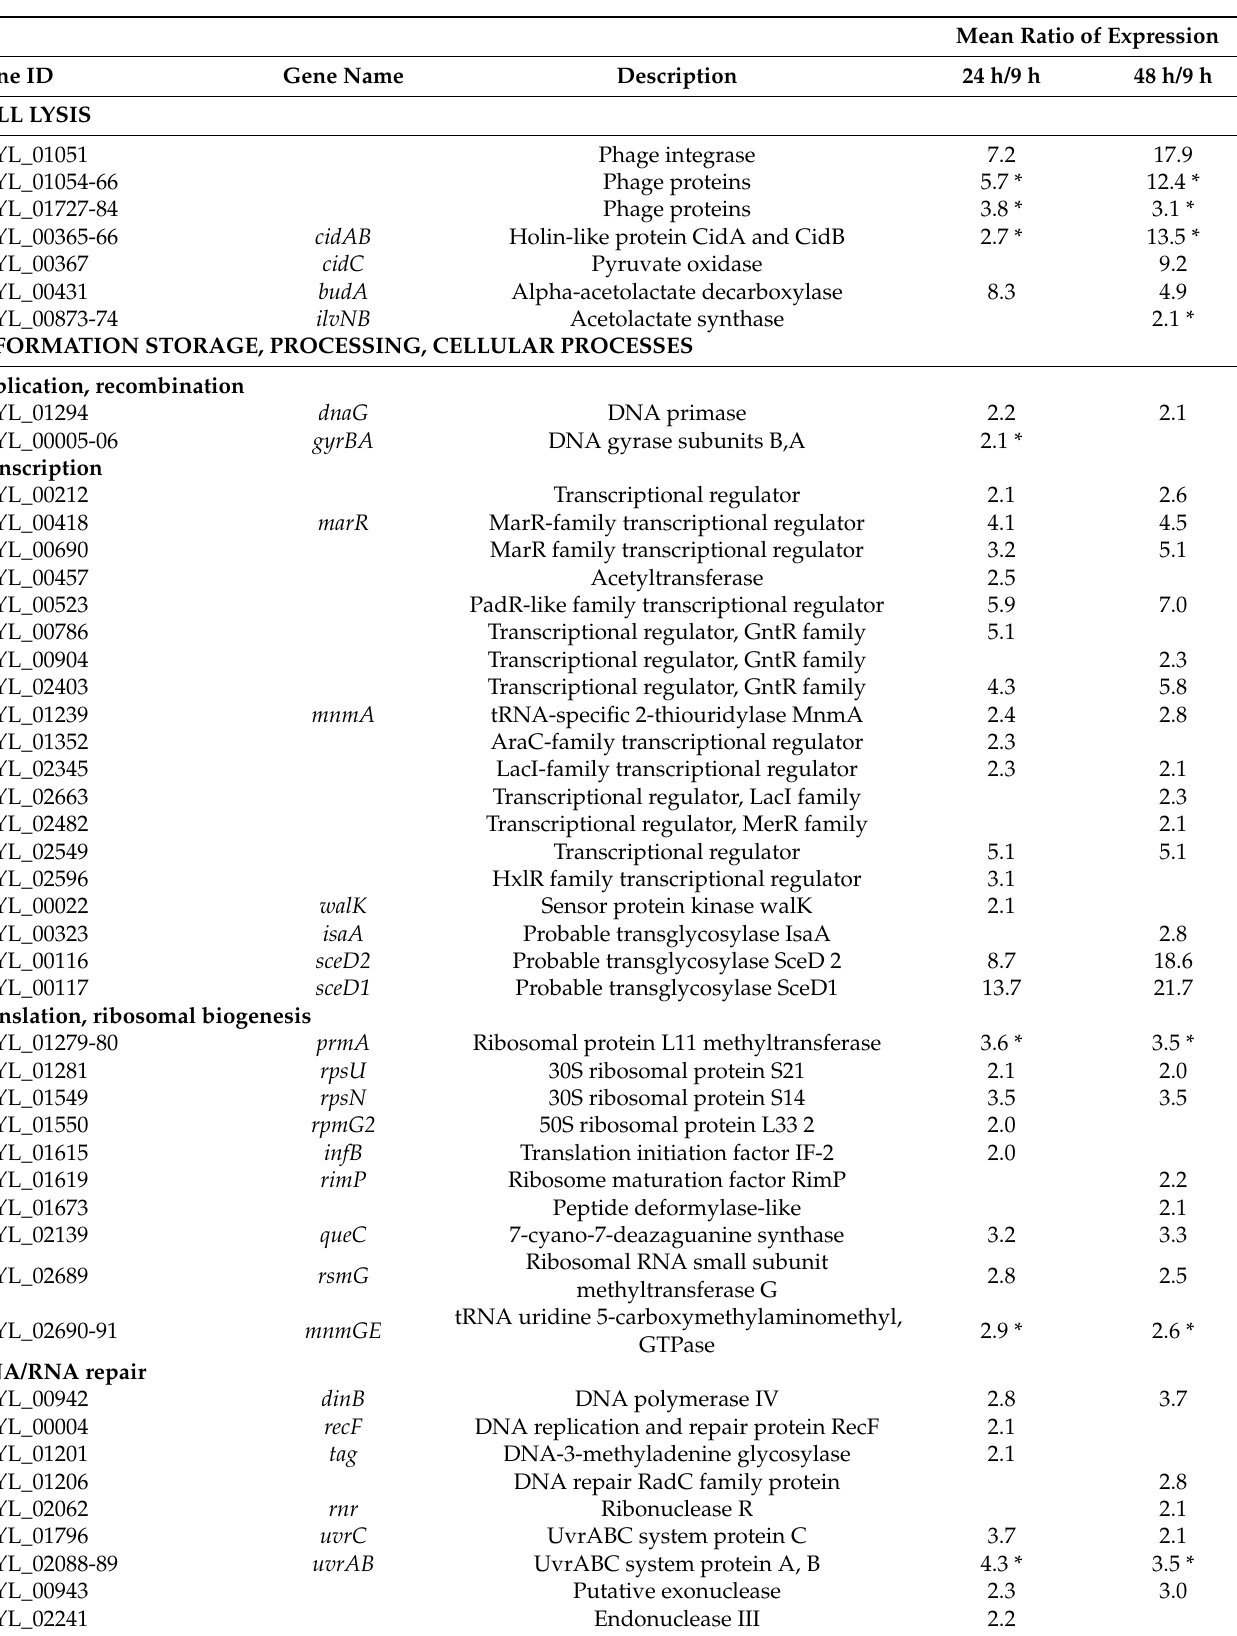
Table 1. Genes of S. xylosus discussed in this study, overexpressed at 24 h and/or 48 h compared to 9 h in biofilm.